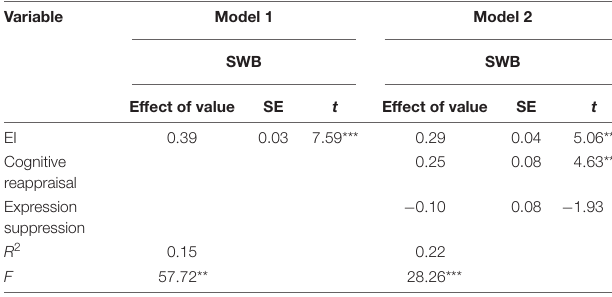
TABLE 3 | Mediation effect model test ( n =